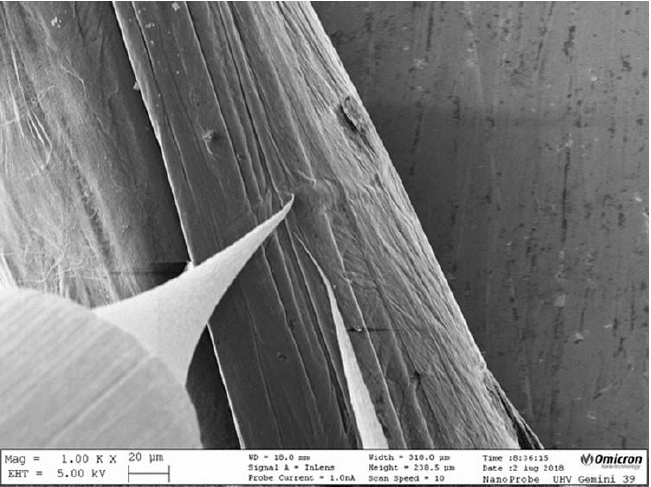
Figure 1. An example SEM image of two tungsten probes 20 µm apart and in contact with the CNT-fiber surface. The probes were used for a two-point-probe I-V measurement in an Omicron nanoprobe between the chosen voltage range as specified in the experimental conditions.